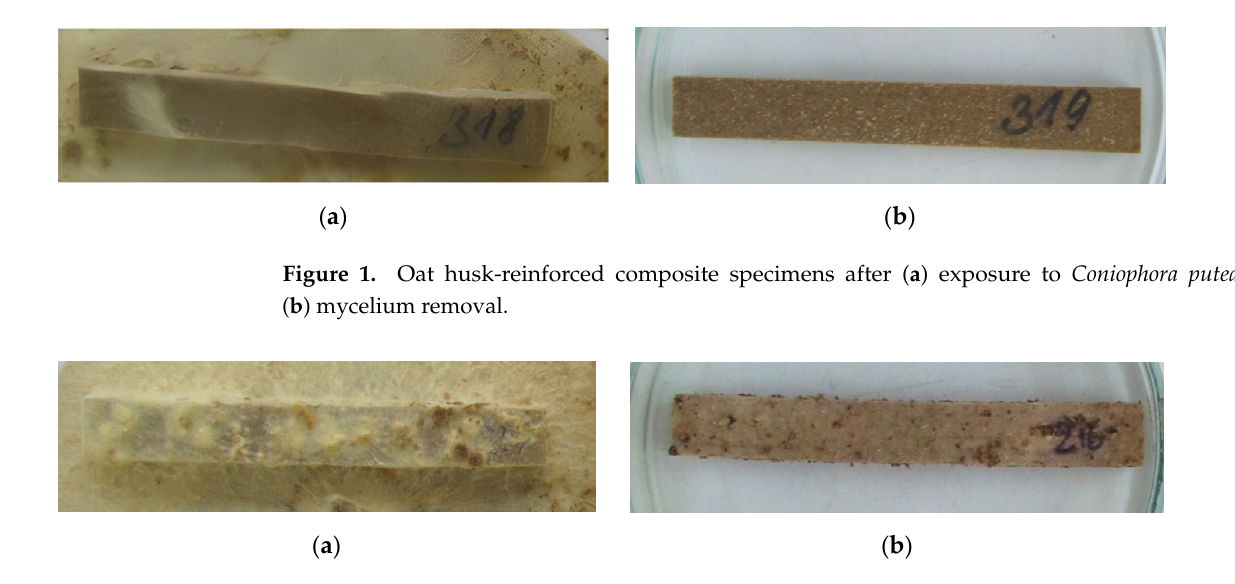
Figure 2. Millet husk-reinforced composite specimens after ( a ) exposure to Coniophora puteana ; ( b ) mycelium removal.